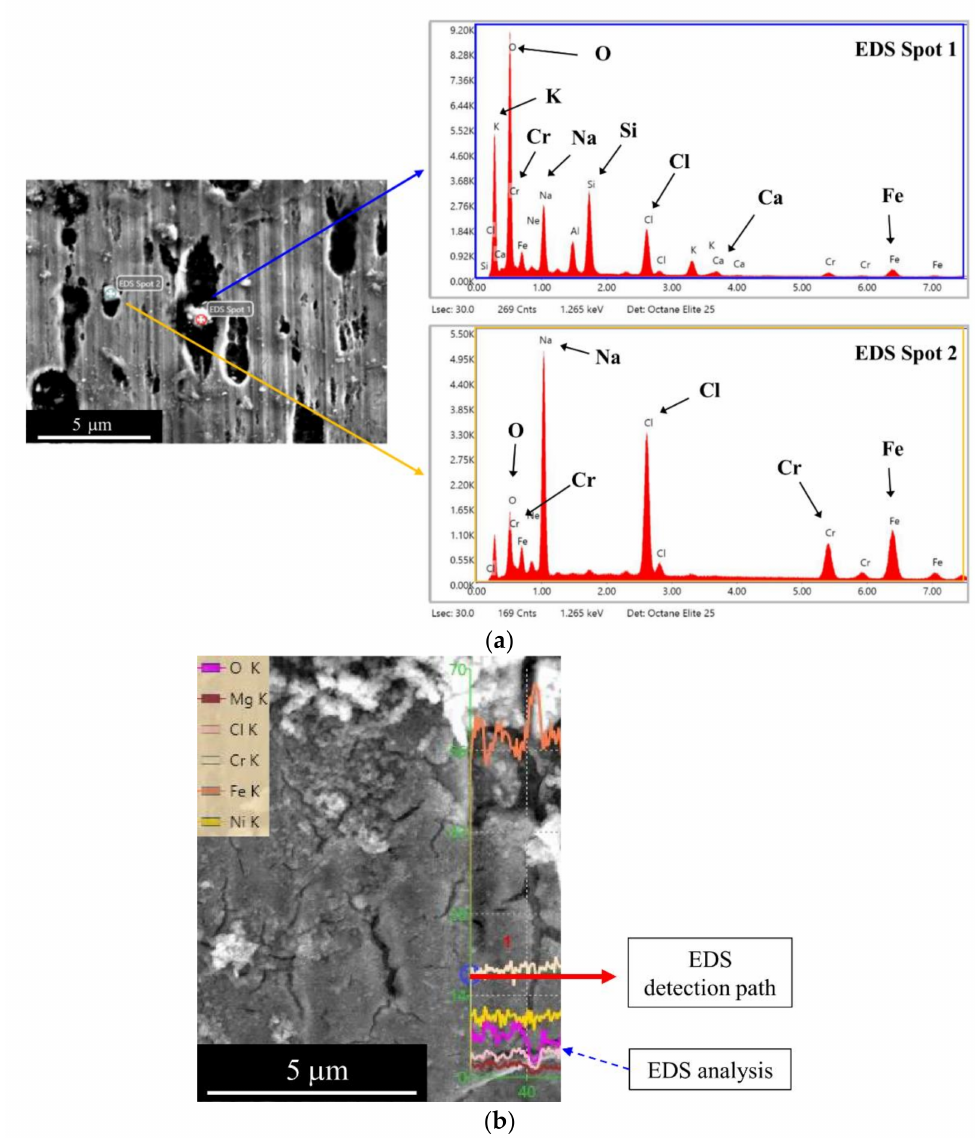
Figure 12. EDS analysis for ( a ) the blunt notch ( r = 2.0 mm) and ( b ) the sharp notch ( r = 0.1